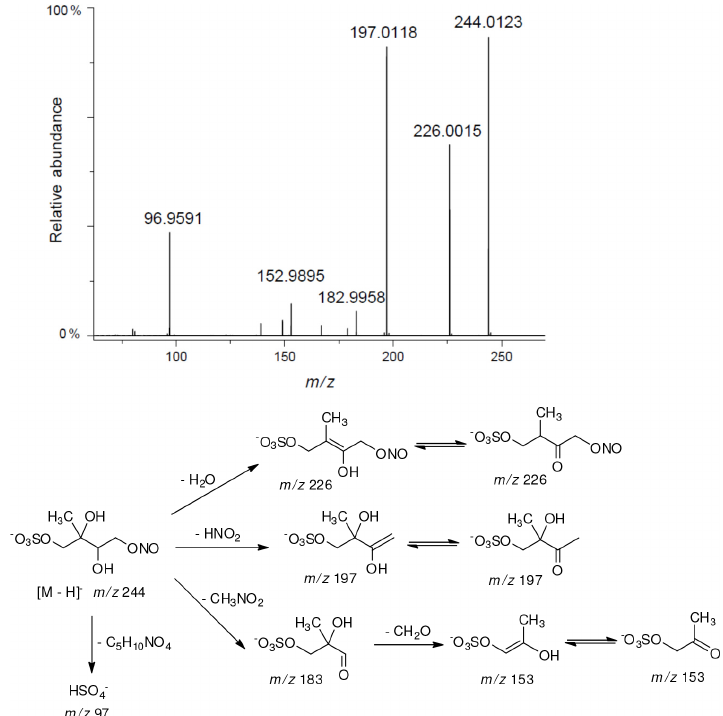
Figure 11. Electrospray product ion mass spectrum ( − ) of 2-methyltetrol nitrosoxy-organosulfate (MW 245) of the RT = 1.35min peak (Fig. 10) acquired for the acidic seed aerosol along with the proposed fragmentation pathway.